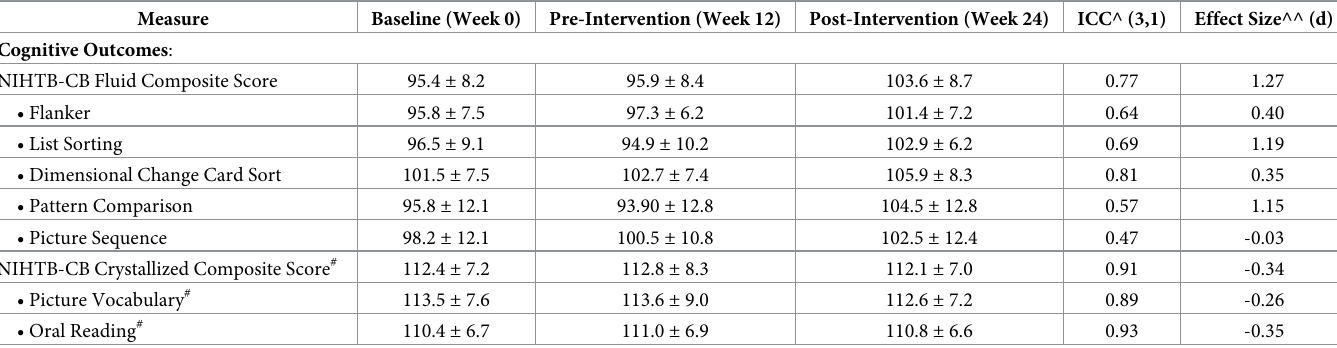
Table 3. Descriptive statistics for cognitive outcomes at baseline, pre-intervention, and post-intervention (N =